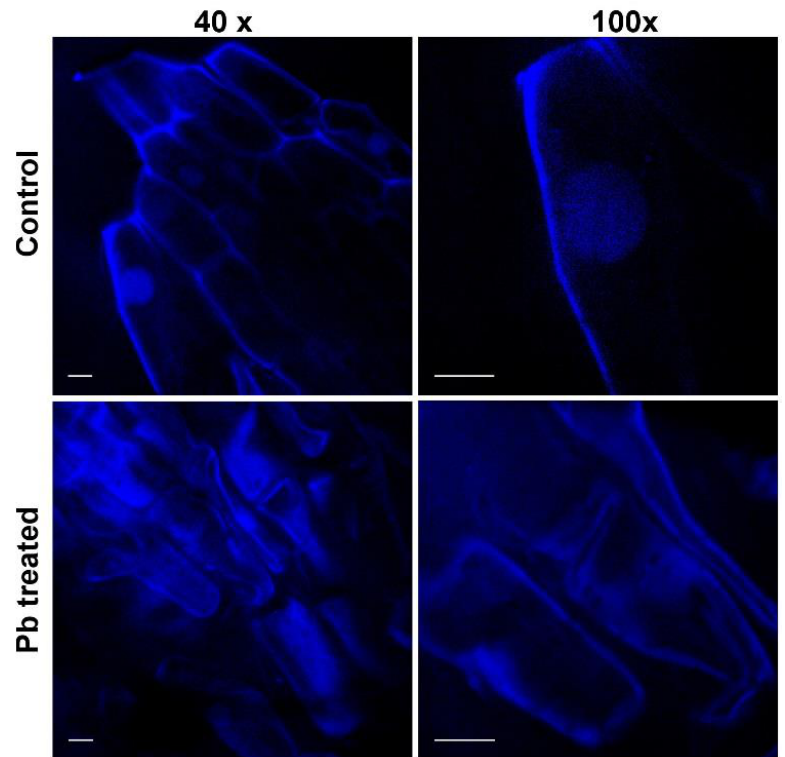
Figure 4. Confocal spinning disk microscope images of the Triticum Aestivum root cells exposed or not to Pb and stained with Hoechst 33324. Images were taken with different magnifications (40×, 100×), and the scale bar represents the same value for all images.